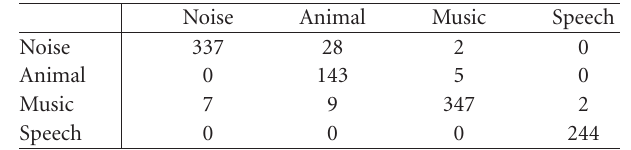
Table 4: Confusion matrix (rows give the decision and columns give the true class) for NRAF short with NN. This gave an accuracy of 91.99%.